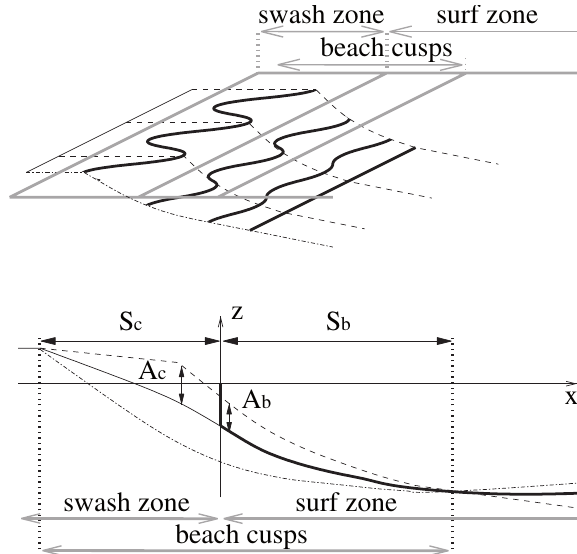
Fig . 3. – Main beach cusp characteristics for a fixed tide. S A are the protruding distance and the amplitude of the part of the c cusps that is in the swash zone, i.e. these parameters are measured and A correspond to the surf zone part of the at Trafalgar Beach. S b b cusps, i.e., where cusps can be interpreted as bars (they are model results). Notice that S and A are measured at low tide, and S c c A change with the tide b